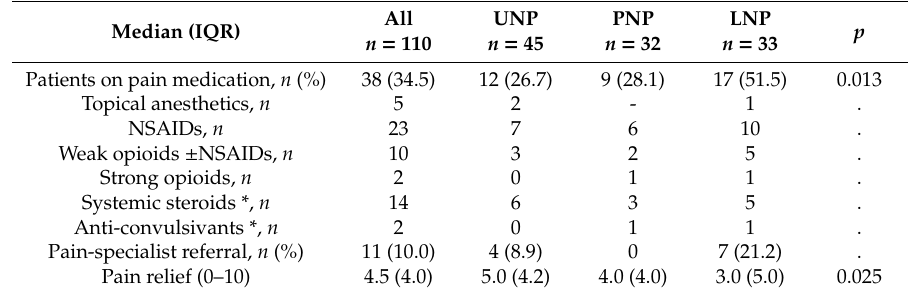
Table 4. Pain management and self-reported pain relief in the hidradenitis suppurativa patients according to PainDetect status: Unlikely Neuropathic Pain (UNP); Possible Neuropathic pain (PNP); Likely Neuropathic Pain